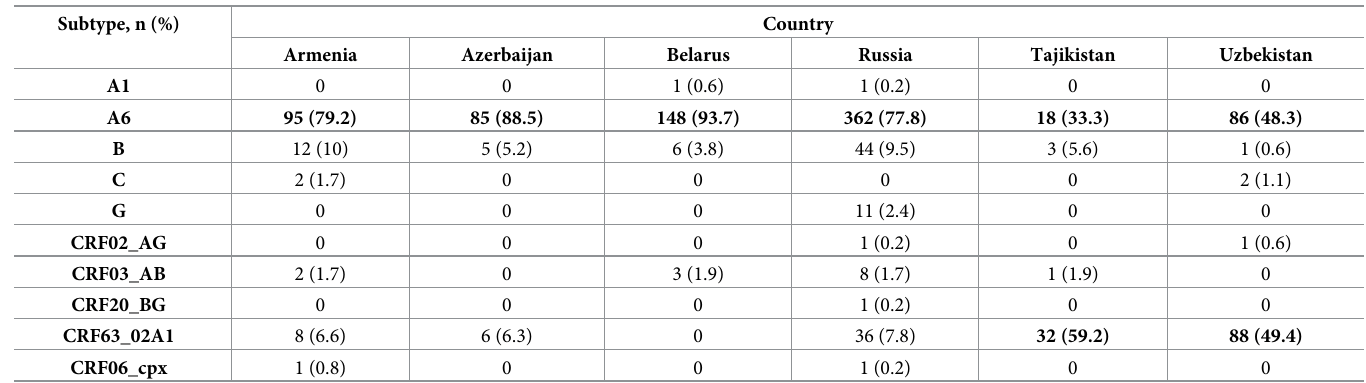
� The numbers in boldface are for the main genetic variant in each country.